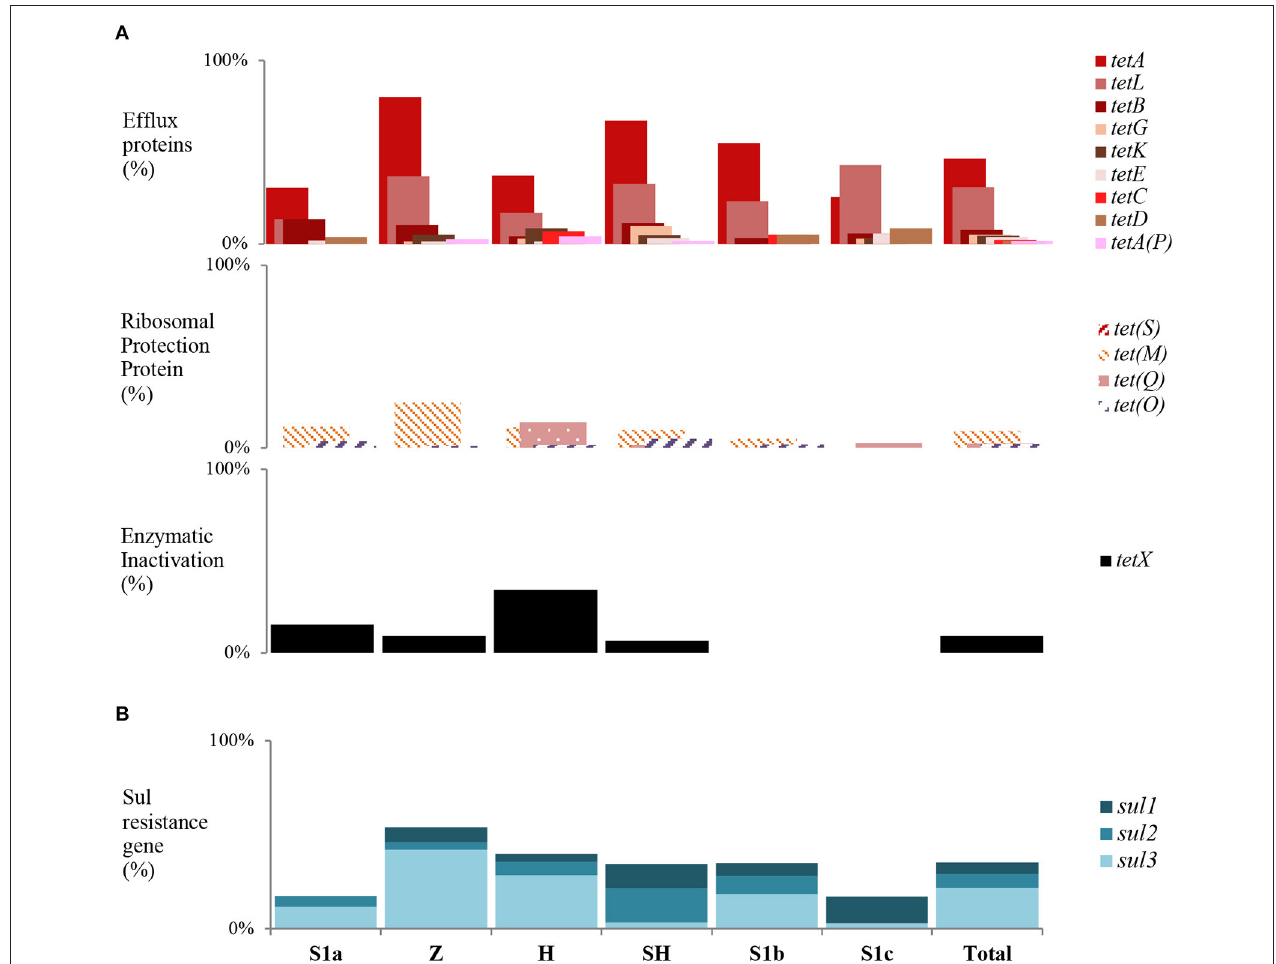
FIGURE 4 | Trends of tet and sul gene among sampling sites in Larut River. (A) tet resistance gene type detected by site (B) Cumulative sul resistance gene type detected by site. Z, Zoo; H, Hospital; SH, Slaughterhouse.